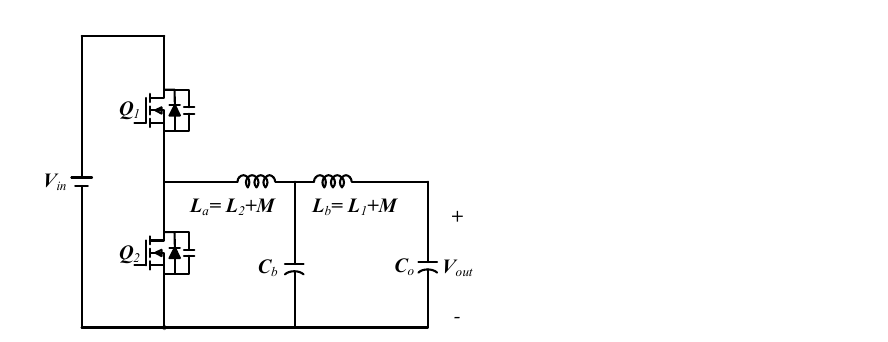
Figure 6. Structure diagram of the equivalent fourth-order LCLC filter of the LC-CC circuit.